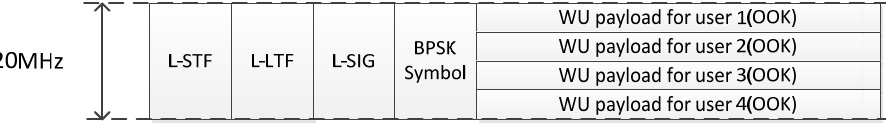
Figure 11. Multiuser format of wake-up frame.